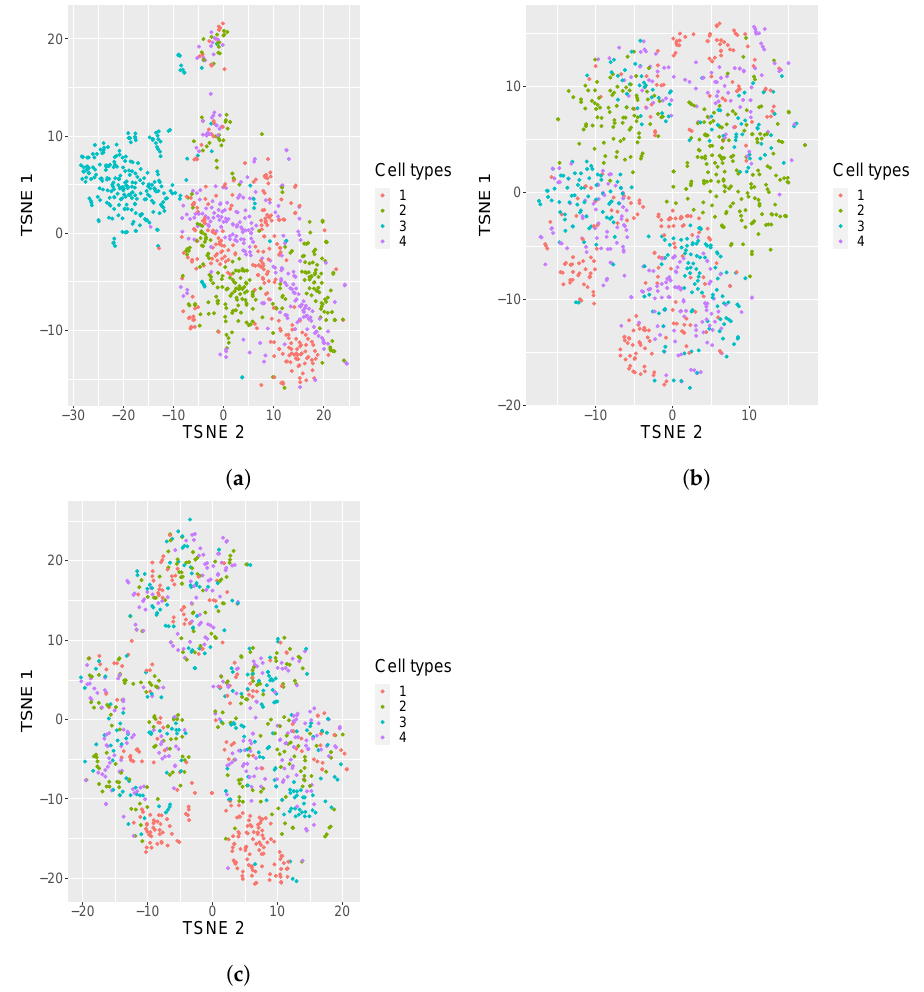
Figure 1. tSNE plots of simulated datasets with varying sparsity or composition of cell types. ( a ) tSNE plots of simulated datasets with 80% sparsity, four equiprobable cell types; ( b ) 95% sparsity, four equiprobable cell types; ( c ) 95% sparsity, unequal number of cell samples from each cell type (i.e., 5%, 15%, 35%,